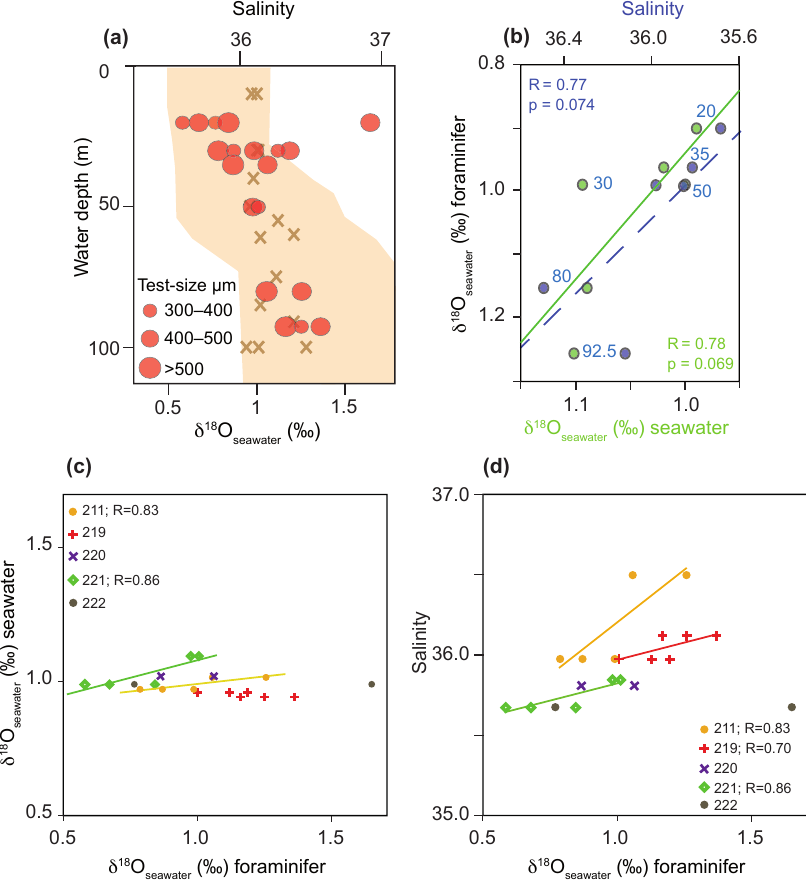
Figure 9. δ 18 O seawater estimates based on foraminiferal tests from living G. sacculifer compared to measured δ 18 O seawater and salinity recorded during cruise M78/1 in the Caribbean Sea and Florida Straits. (a) Red dots indicate the average δ 18 O seawater estimates of bulk samples from different test size fractions; brown crosses indicate the in situ δ 18 O seawater (‰ VSMOW); the orange envelope indicates salinity. (b) Relationship between average δ 18 O seawater estimates (foraminiferal tests), measured δ 18 O seawater (seawater) and measured in situ salinity. Blue and green dots indicate average values at a specific water depth (blue numbers denote average sampling water depth in metres). (c) Relationship between δ 18 O seawater estimates (foraminiferal tests) and measured δ 18 O seawater (seawater) for each station. (d) Relationship between δ 18 O seawater estimates (foraminiferal tests) and measured salinity for each